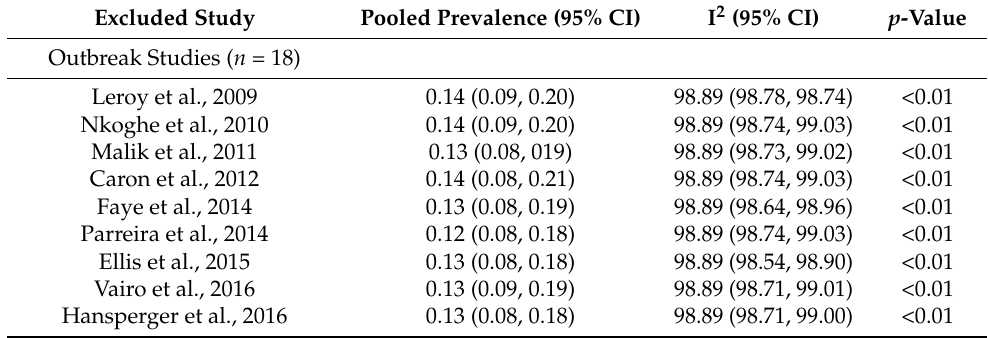
Table 3. Sensitivity analysis of dengue virus prevalence based on prospective cross-sectional